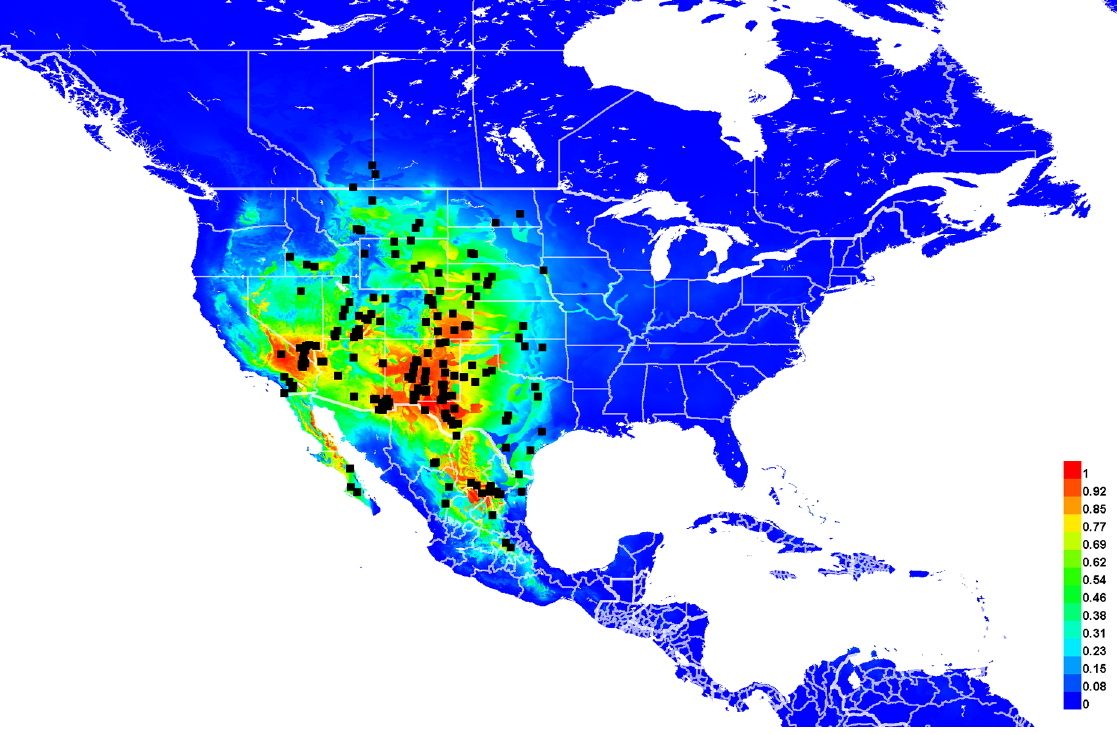
Fig. 42. Georeferenced collection records of Lasioglossum ( D. ) hudsoniellum (Cockerell, 1919) (black squares) and predicted distribution by maximum entropy ecological niche modeling in Maxent (colour shading). Warmer colours indicate higher cloglog probability of